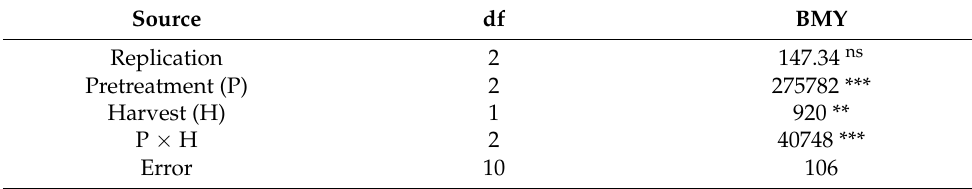
Table 4. Two-way ANOVA on biomethane yield (BMY) of untreated and fungal pretreated giant reed in winter and autumn harvests. Degree of freedom (df) and adjusted mean square significance: